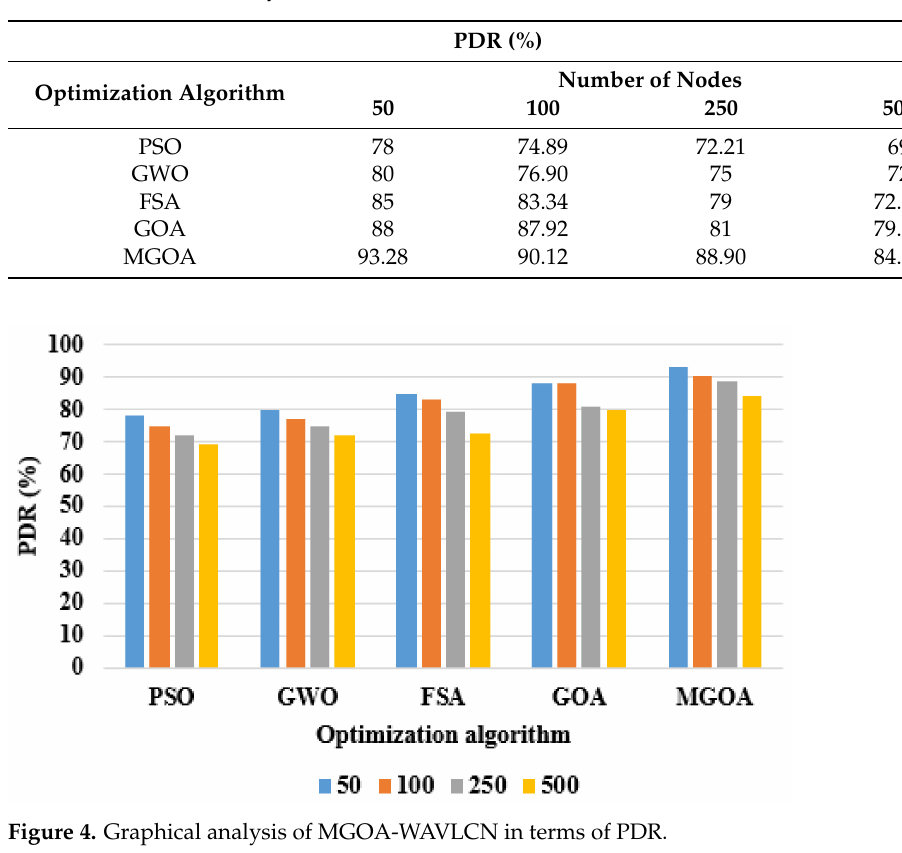
Figure 3. Graphical analysis of MGOA-WAVLCN in terms of throughput. Table 4. Performance analysis of MGOA-WAVLCN in terms of PDR.